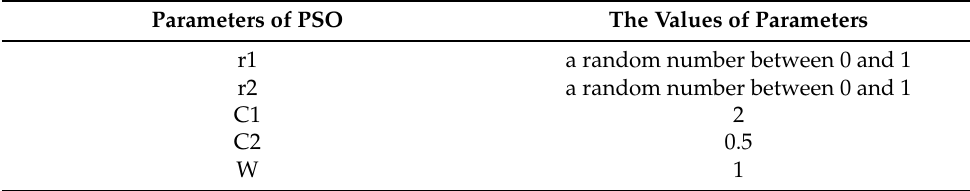
Table 1. The parameters of PSO in the